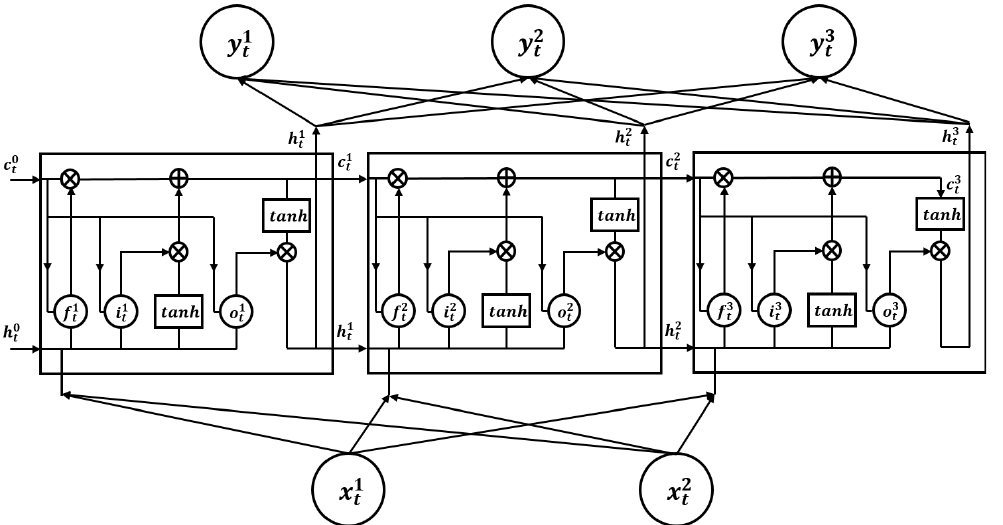
Figure 4. An architecture of long short-term memory networks by